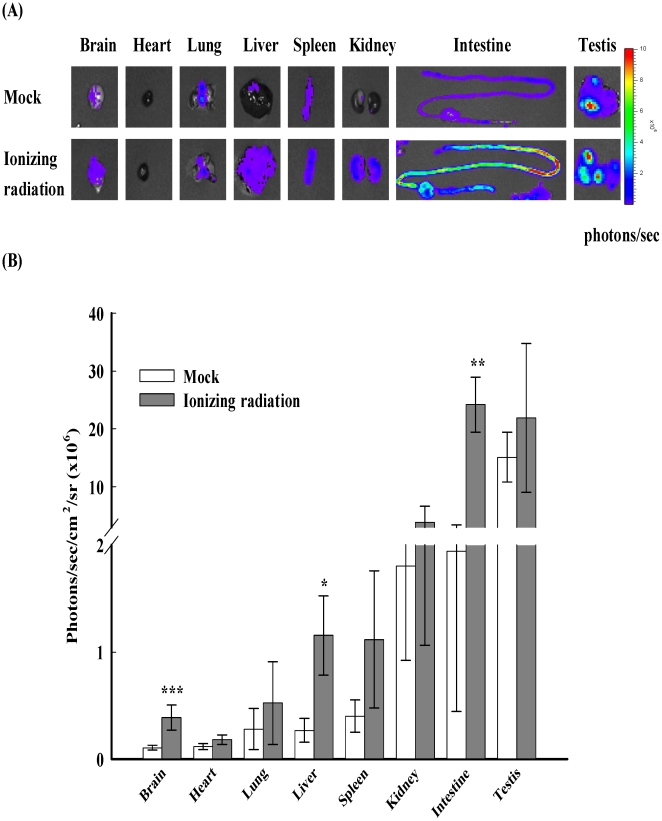
NF-κB-dependent bioluminescence in individual organs.Transgenic mice were exposed to ionizing radiation. Three hours later, mice were sacrificed and organs were subjected to image. (A) Ex vivo imaging. The color overlay on the image represents the photons/sec emitted from the organ, as indicated by the color scale. Photos are representative images (n = 10). (B) Quantification of photon emission from the organ. Values are mean ± standard error (n = 10). * p<0.05, ** p<0.01, *** p<0.001, compared with mock.